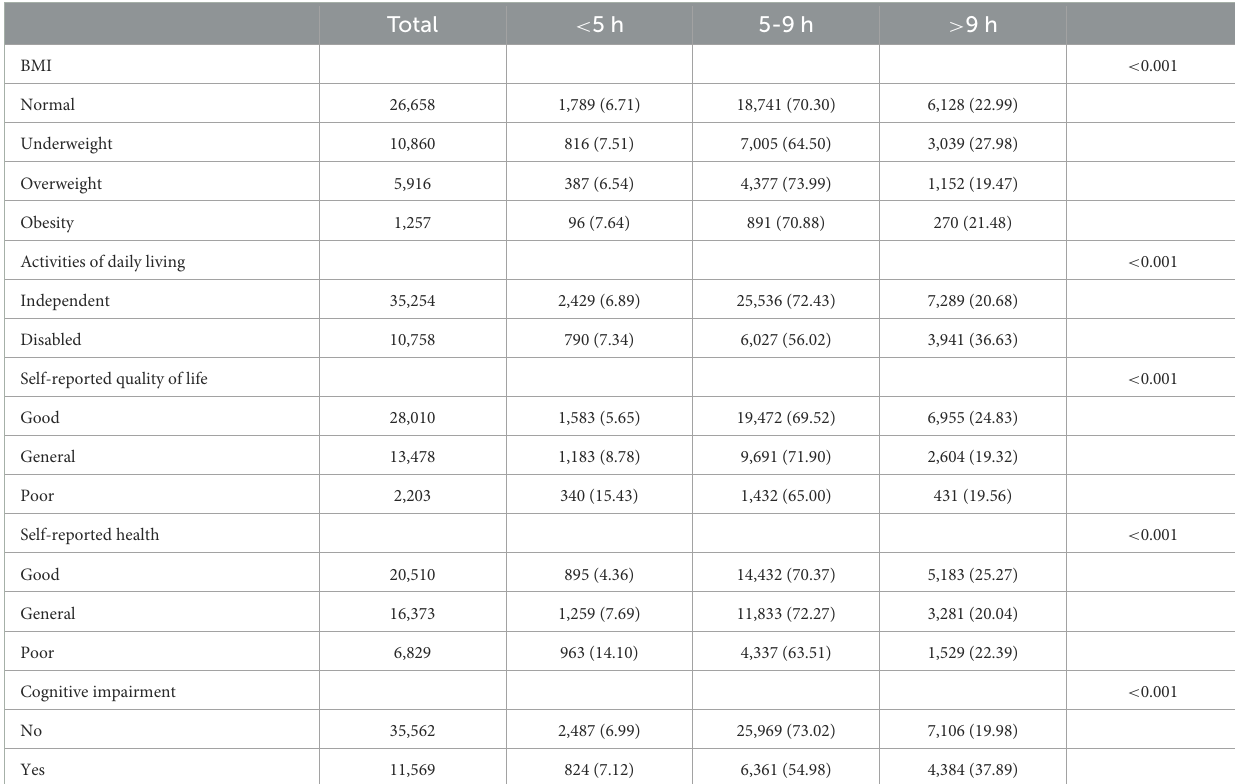
In contrast to short sleep duration, the odds of long sleep duration were not increased in 2011 and 2014; however, the likelihood of long sleep duration was decreased in 2018 compared with 2008: aOR = 0.98 (95% CI: 0.91–1.06) in 2011, aOR =